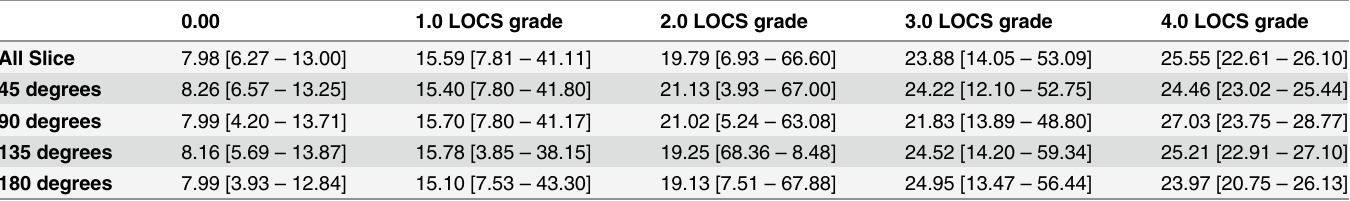
Table 2. Averages Intensities Summary (Median [Minimum Value – Maximum Value]) within each Slice and the Average of the Four Slices for the Control Group (0.00) and each Lens Opacity Classification System (LOCS) Grade.